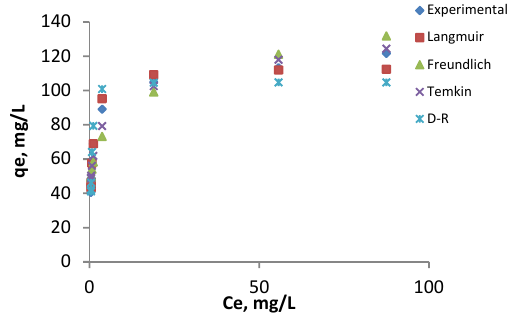
Fig.5. Fitting of the adsorption models to the experimental